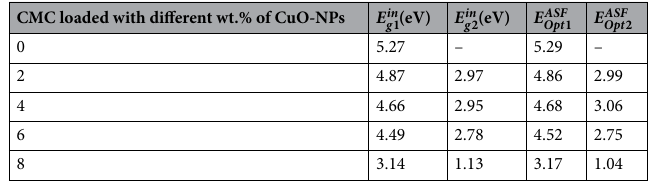
Table 5. Indirect allowed band gap values of CMC and CMC doped with 2, 4, 6 and 8 wt. % CuO.